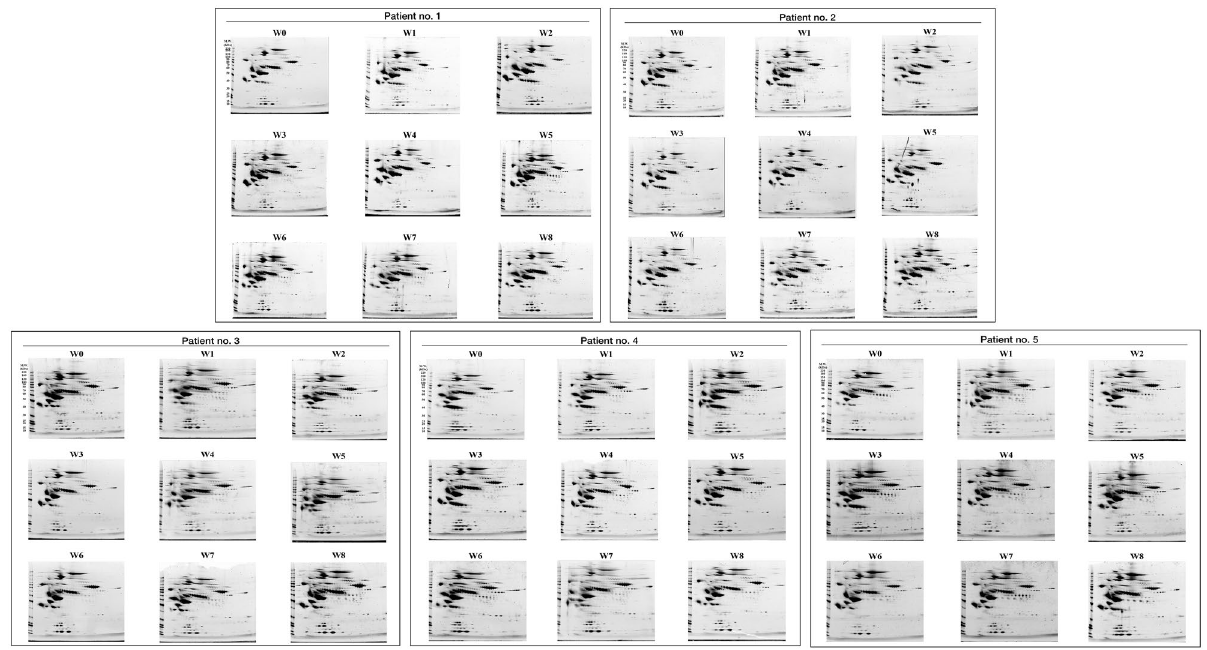
Figure 1. Two-dimensional gel electrophoresis (2-DE) images of serum obtained from five patients. W0 represents Week 0, sample collected before hematopoietic stem cell transplantation (HSCT); W1-W8 represent Week 1 to Week 8, samples collected weekly after patient has undergone HSCT treatment. Protein separation by 2-DE is performed using a non-linear wide range (pH 3–10) immobilized pH gradient in the first dimension and 4–12% polyacrylamide gel using 15 µg of serum protein. Data acquisition is done in randomized